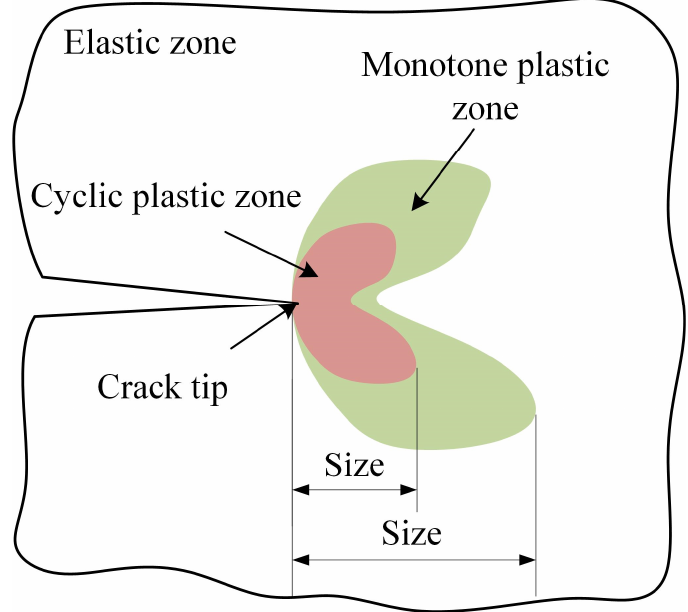
Figure 15. The definition of plastic zone size.